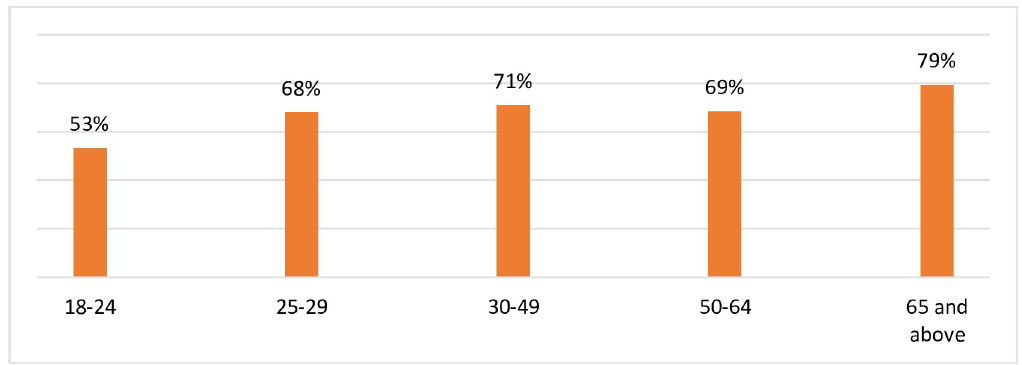
Fig 3. Distribution of respondents maintaining wellbeing by age: South Australia 2020. Source: Figures generated by the authors from results of Impact of COVID-19 on the wellbeing of individuals in South Australia 2020 survey.